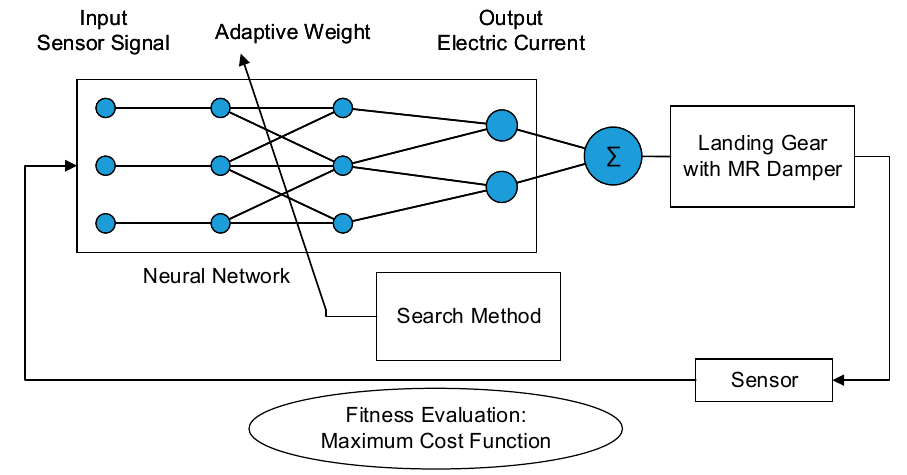
Figure 4. Landing gear learning process.